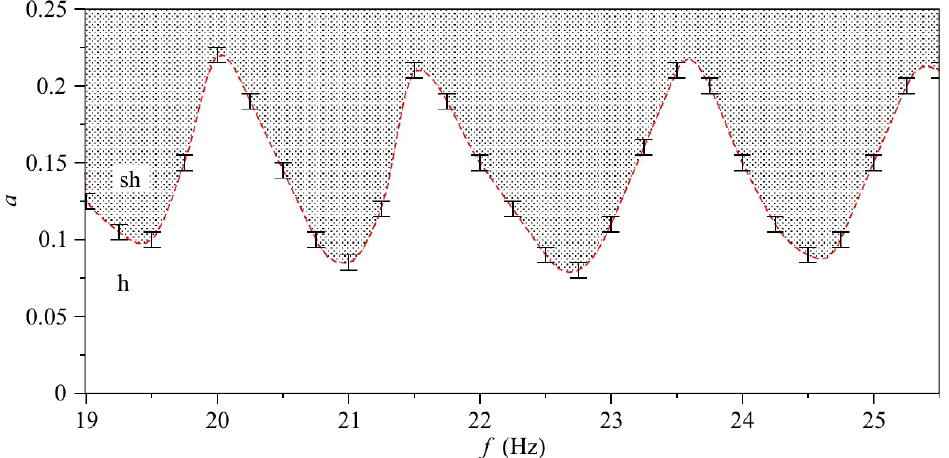
Figure 21. Frequency-amplitude phase diagram of the harmonic (h) and subharmonic (sh) responses for a fixed volume ethanol drop vertically vibrated with the frequency f . The response is subhar- monic in the shaded area, where the generation of AFCs has been observed. Reproduced from [23]. Copyright 2019 by the American Physical